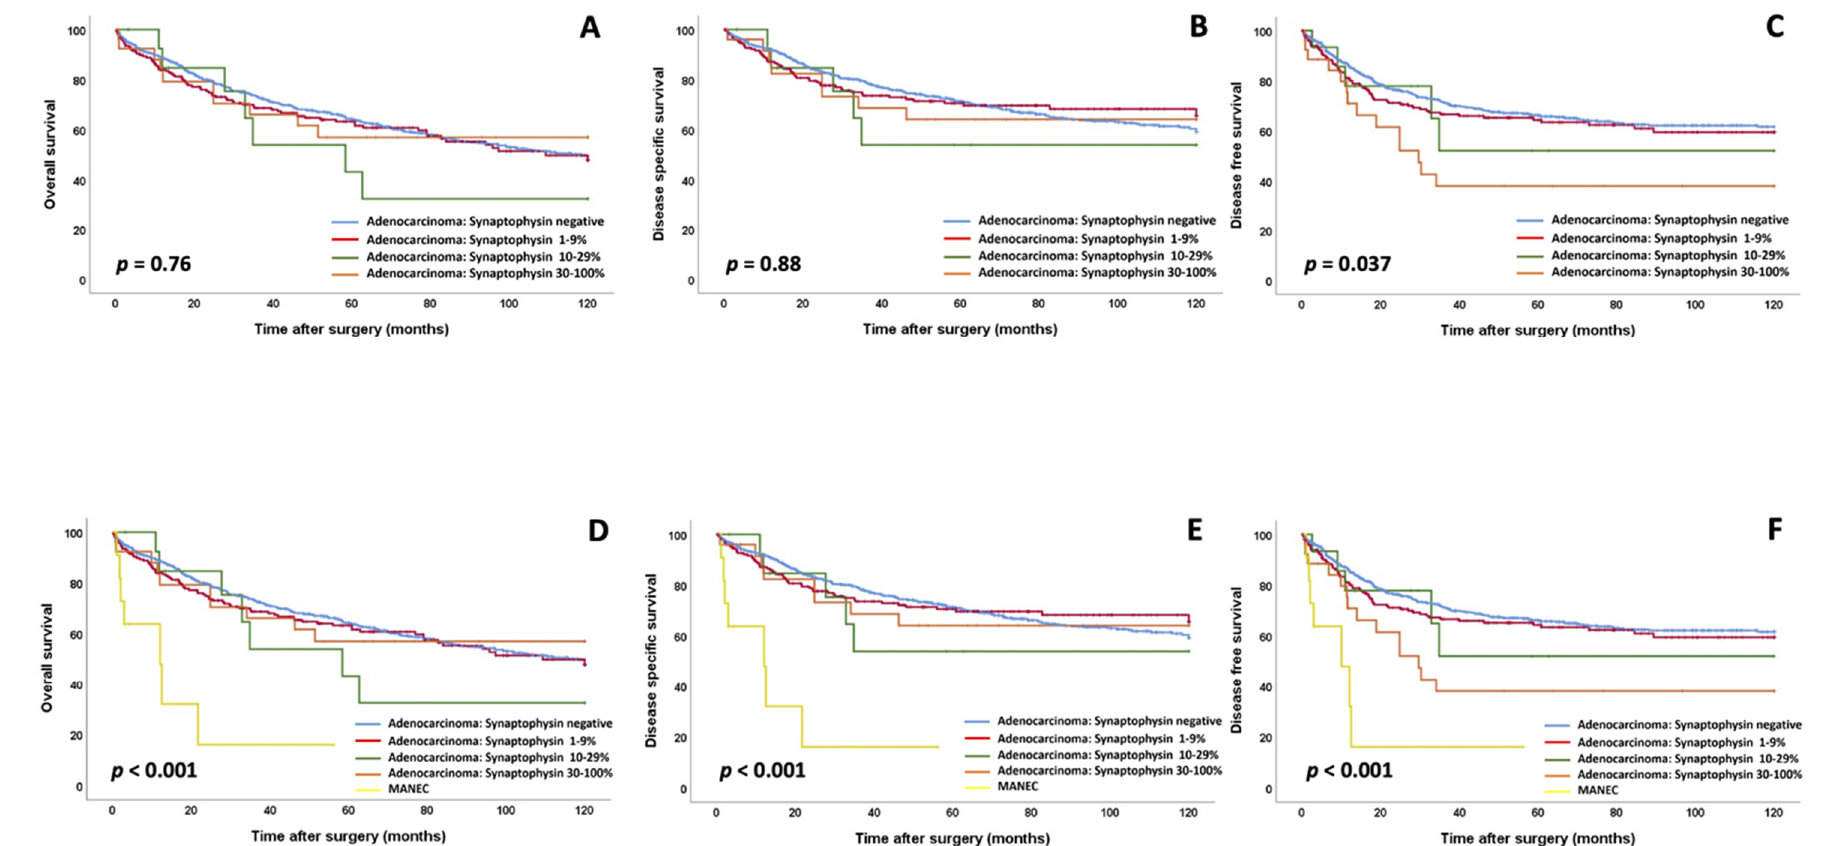
Figure 3. ( A – C ) Overall survival, disease-specific survival and disease-free survival for synaptophysin expression groups in conventional adenocarcinomas with a non-neuroendocrine morphology ( A – C ); note that there are no survival differences between synaptophysin expression groups in conventional adenocarcinomas and only a slightly reduced disease-free survival for conventional adenocarcinomas with a synaptophysin expression of 30% or more. ( D – F ): Overall survival, disease-specific survival and disease-free survival for synaptophysin expression groups in conventional adenocarcinomas compared to typical MANECs ( D – F ); please note that while the conventional adenocarcinomas show similar survival characteristics, the MANECs show significantly unfavorable survival characteristics.